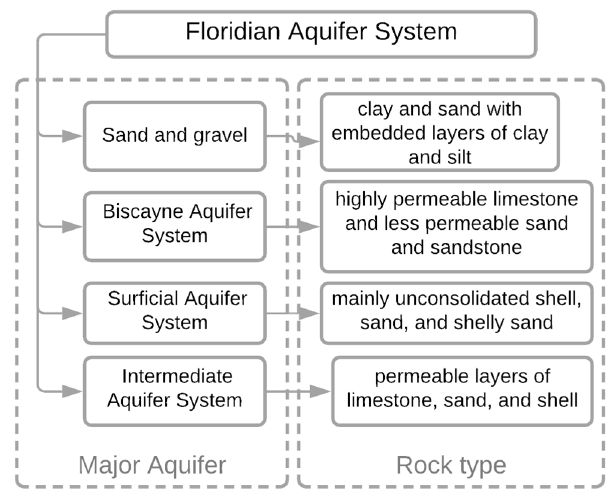
Figure 2. A schematic of a hydrogeological section of the study